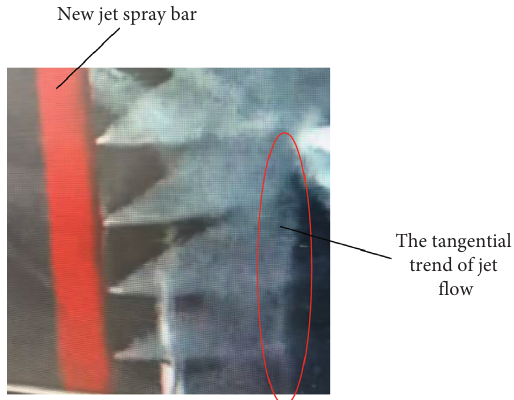
Figure 21: Nozzle jet after modification.